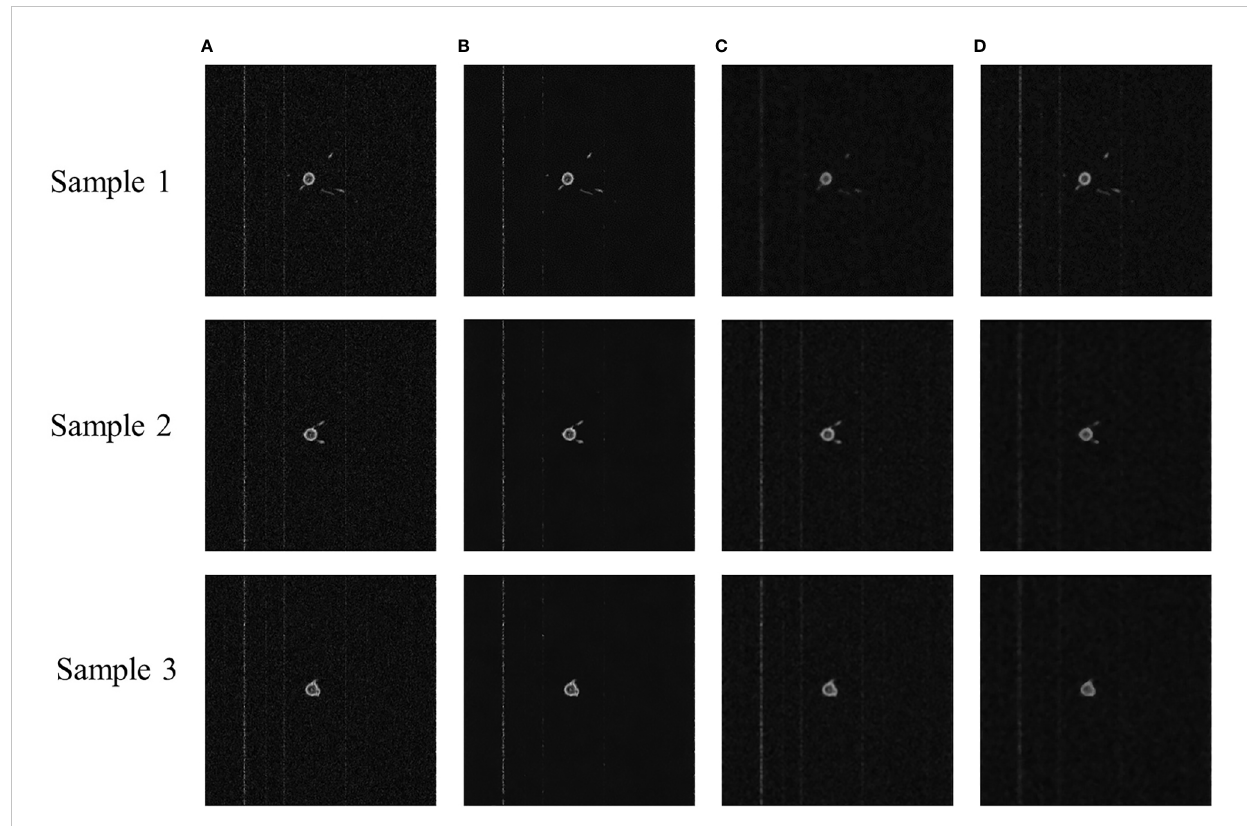
TABLE 3 The segmentation results of the MRI images of the cotton root systems. model Dice mIoU Precision